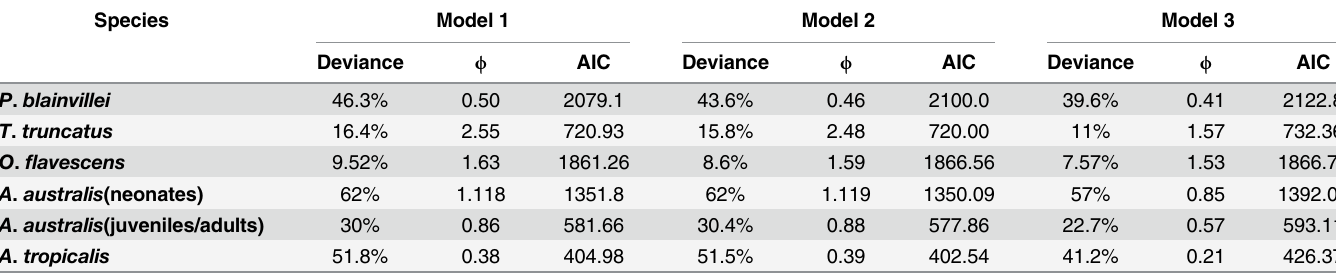
Table 3. GAM results for each species modeled. Over-dispersion parameter ( ϕ ).